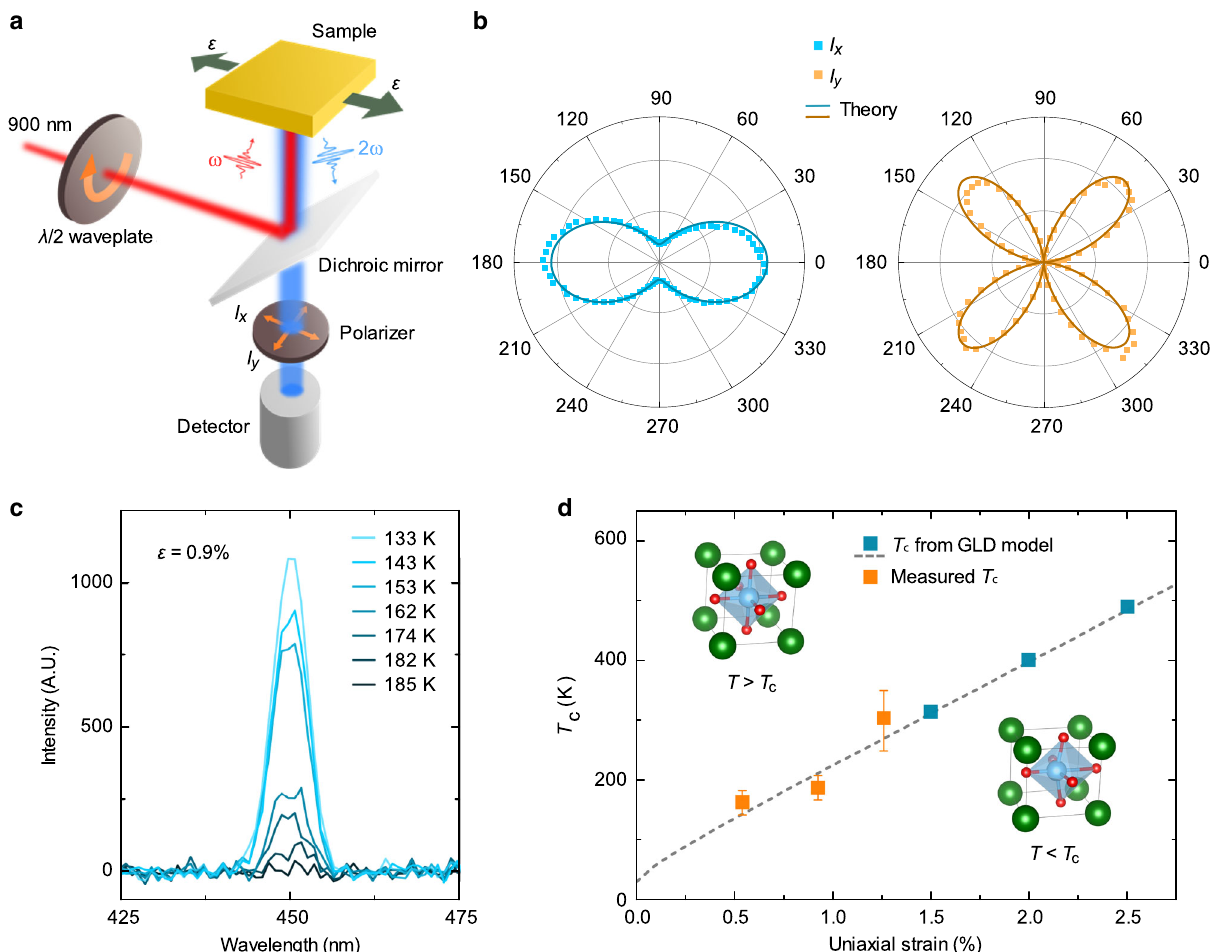
Fig. 3 Optical second harmonic generation (SHG) measurements of SrTiO 3 membranes. a Schematic illustrating the experimental setup for SHG measurements, wherein a 900nm fundamental beam is used to excite the frequency-doubled signal from membranes in a re fl ection geometry that can be probed at a wavelength of 450 nm. b SHG polar plots measured at room temperature as a function of incident beam polarization in membranes strained at 2.0%. c SHG signals measured as a function of temperature in membranes strained at 0.9%. d T c plotted as a function of uniaxial strain directly measured from the SHG measurements, as well as high temperature extrapolations of the Ginsburg – Landau – Devonshire model. Error bars represent the standard